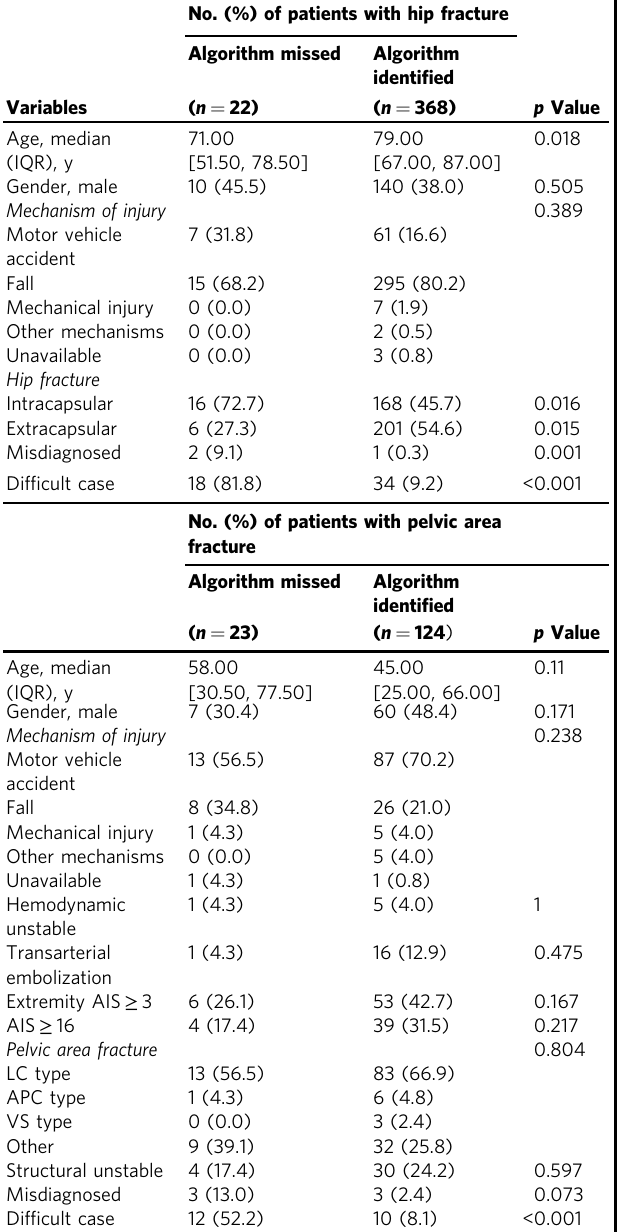
Table 3 The characteristics of the algorithm identi fi ed and missed trauma fi ndings regarding hip fracture and pelvic fracture.